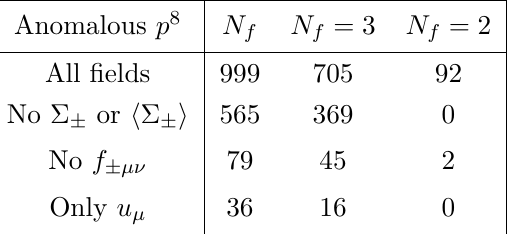
Table 10 . Breakdown of the anomalous operators at p 8 in the chiral